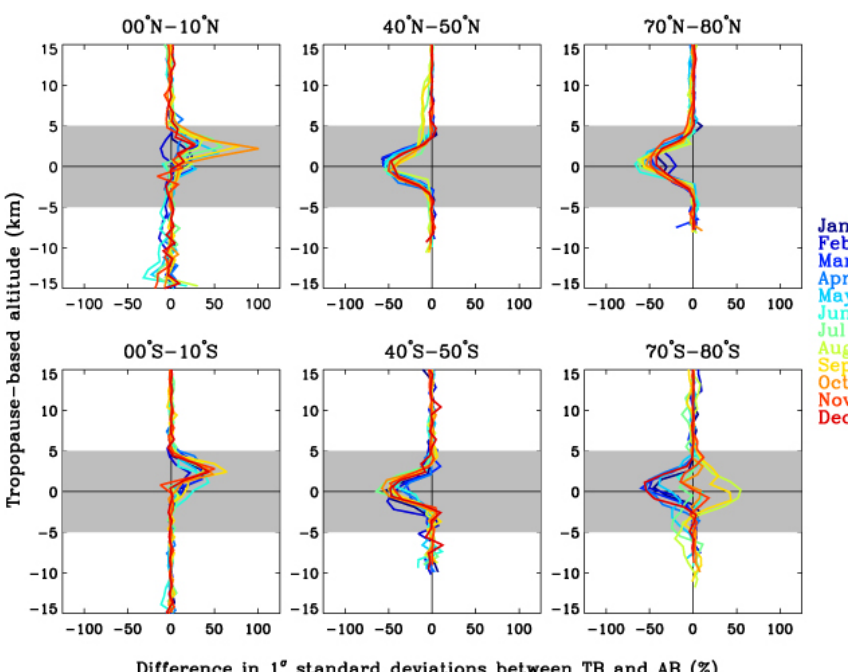
Fig. 3. Same as Fig. 1, but for the improved version of the TB climatology. The TB climatology is derived using sonde profiles with tropopause height greater than 14km for ± 5 ◦ and with tropopause height less than 14km for ± 45 and ± 75 ◦ . The TB coordinate is defined using the variable shifting offset through Eqs. (1) and